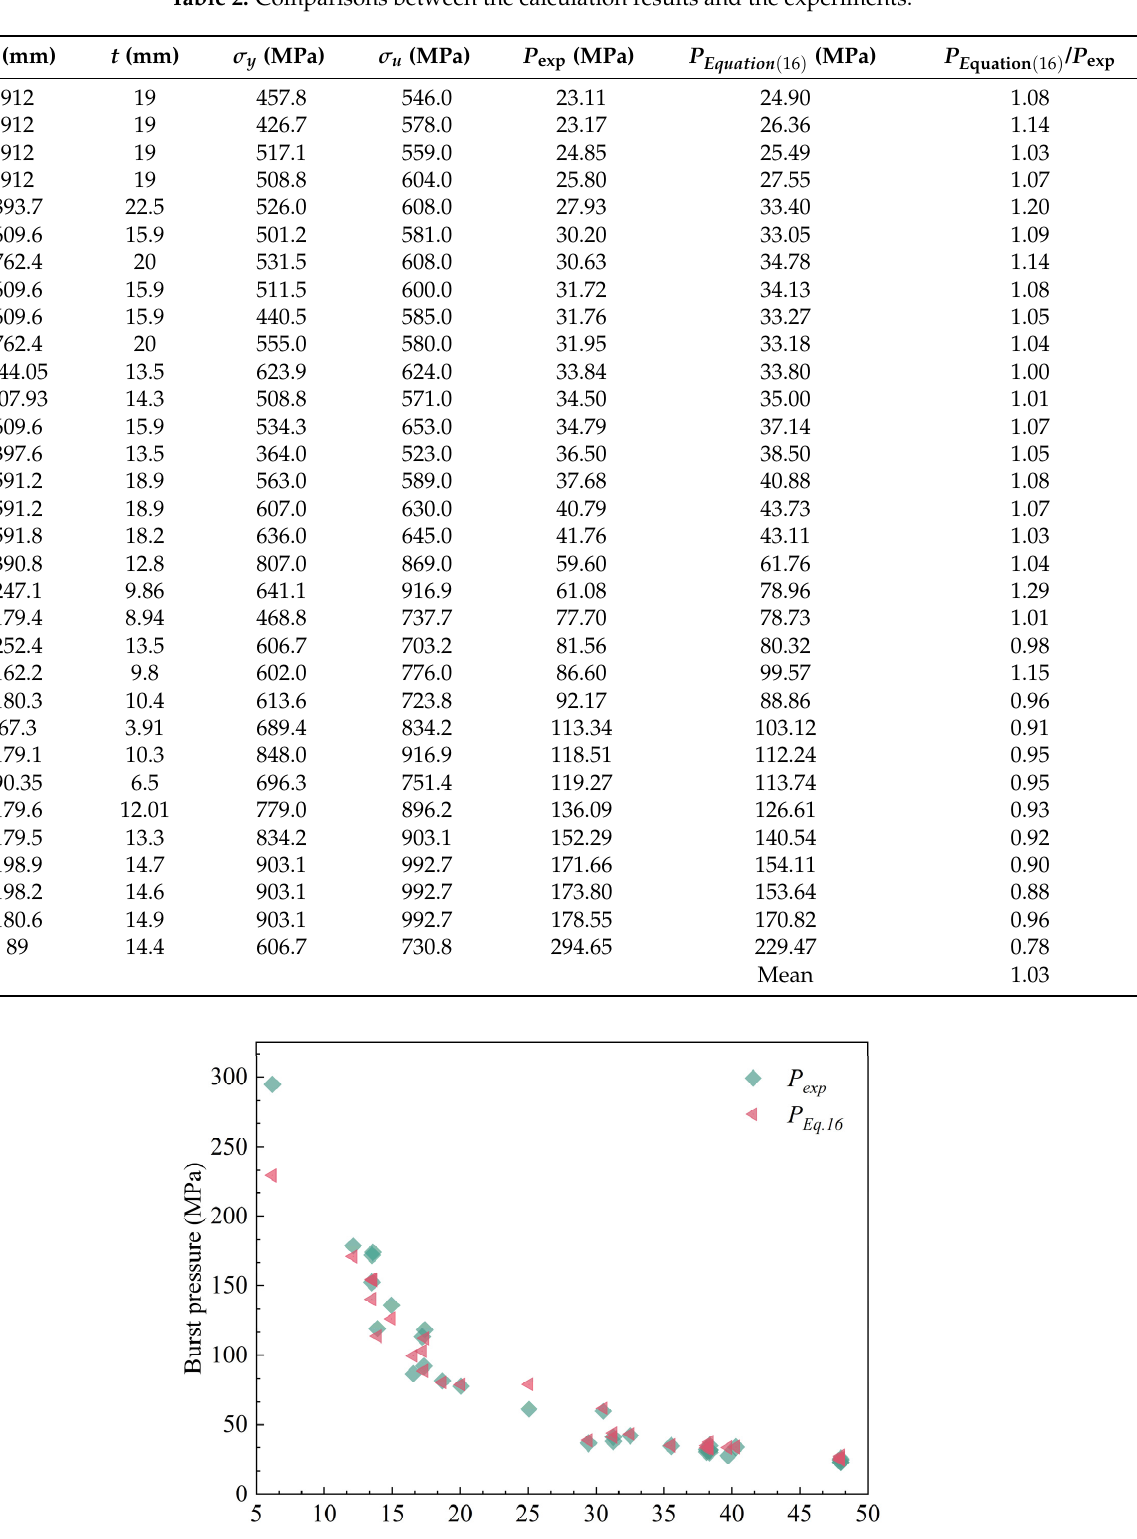
Table 2. Comparisons between the calculation results and the experiments.